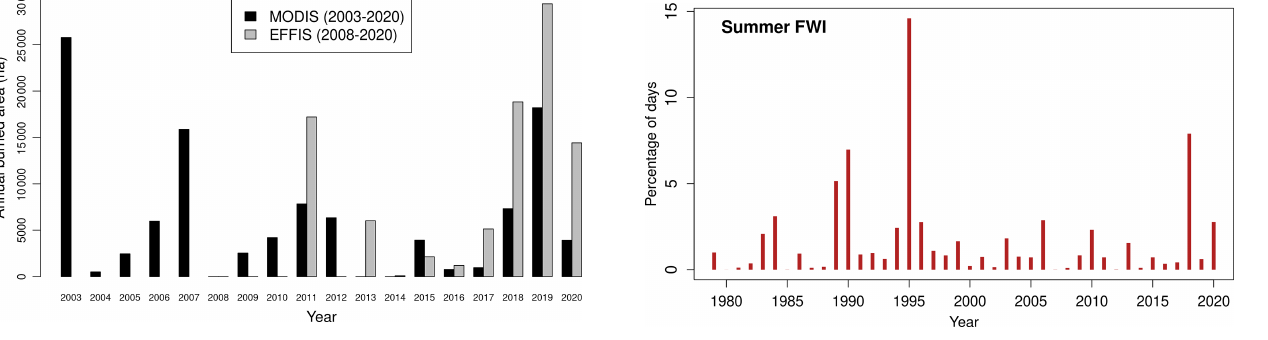
Figure 5. Annual percentage of summer (June–July–August) days, 1979–2020, averaged over the UK, with very high fire danger (FWI > 17.35), based on ERA5 reanalysis